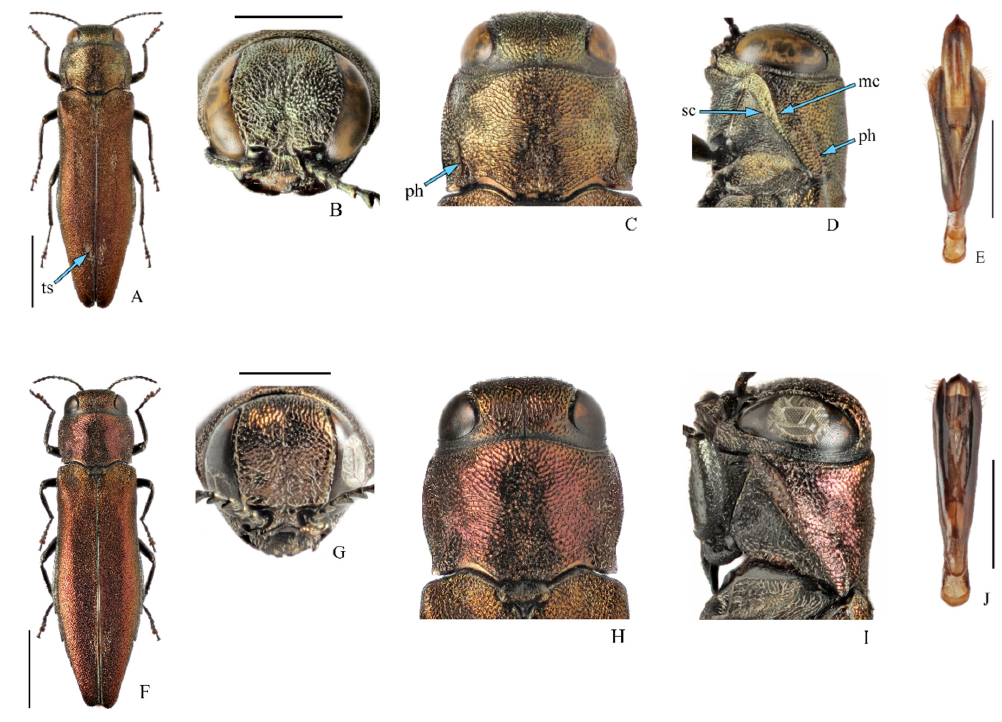
Figure 1. ( A – E )— Agrilus mali Matsumura, 1924, male. ( A )—Habitus; ( B )—head; ( C )—pronotum, dorsal view; ( D )—same, lateral view; ( E )—aedeagus, dorsal view. ( F – J )— Agrilus sinuatus sinuatus (Olivier, 1790), male. ( F )—Habitus; ( G )—head; ( H )—pronotum, dorsal view; ( I )—same, lateral view; ( J )—aedeagus, dorsal view. mc —marginal carina, ph —prehumerus, sc —submarginal